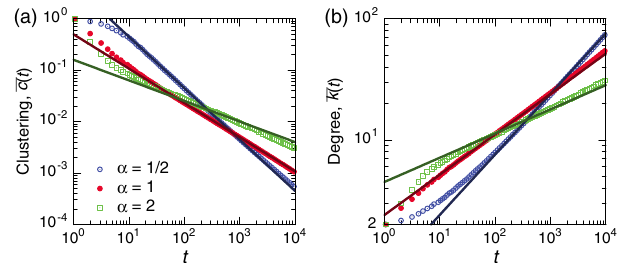
FIG. 3. Expected time courses of (a) clustering and (b) degree as a function of time since injection t for growing networks with different attachment exponents (cid:1) . Straight lines correspond to (cid:2) k ð t Þ (cid:1) t 1 = ð 2 (cid:1) þ 1 Þ . We observe the predictions (cid:2) c ð t Þ (cid:1) t (cid:2) 2 = ð 2 (cid:1) þ 1 Þ and same scaling for growing and stationary systems, though the latter additionally feature a system-size-dependent exponential cutoff.